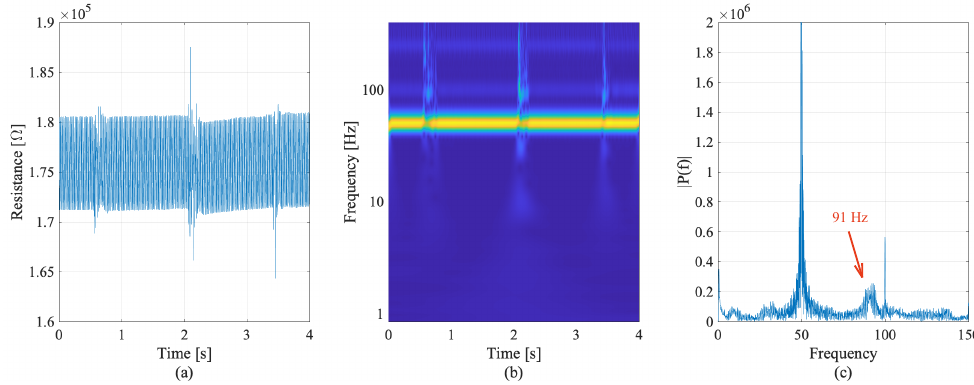
Figure 12. Resistance time history ( a ), frequency–time analysis ( b ), and frequency response ( c ) of second embedded smart concrete cube sensor during hammer hit